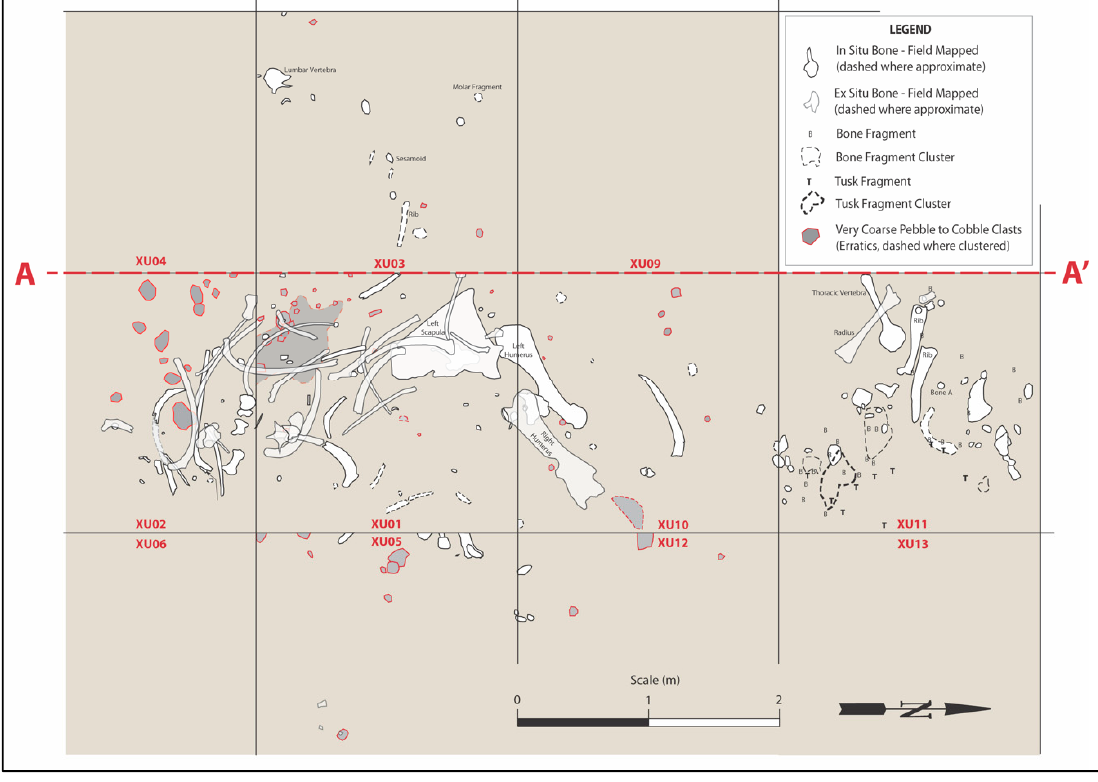
Figure 5. Distribution of bone specimens and ice-rafted erratics at the Coyote Canyon Mammoth Site through 2019, in plan view projected to multiple excavation unit floor levels (see Figure 4b). The line A-A’ delineates the location of the stratigraphic cross section in Figure 6.